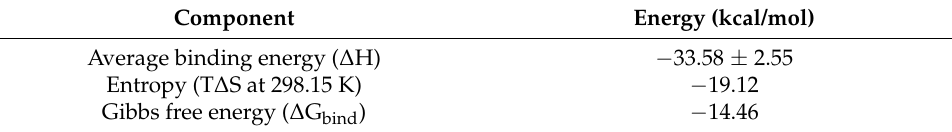
Table 3. Binding energies of ( R )-linalool dimer and BCD dimer from MM/GBSA